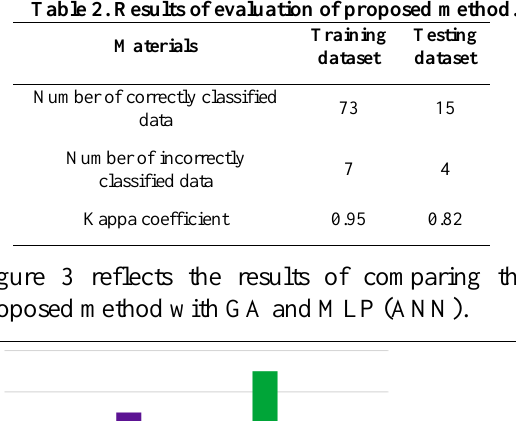
Table 2. Results of evaluation of proposed method.